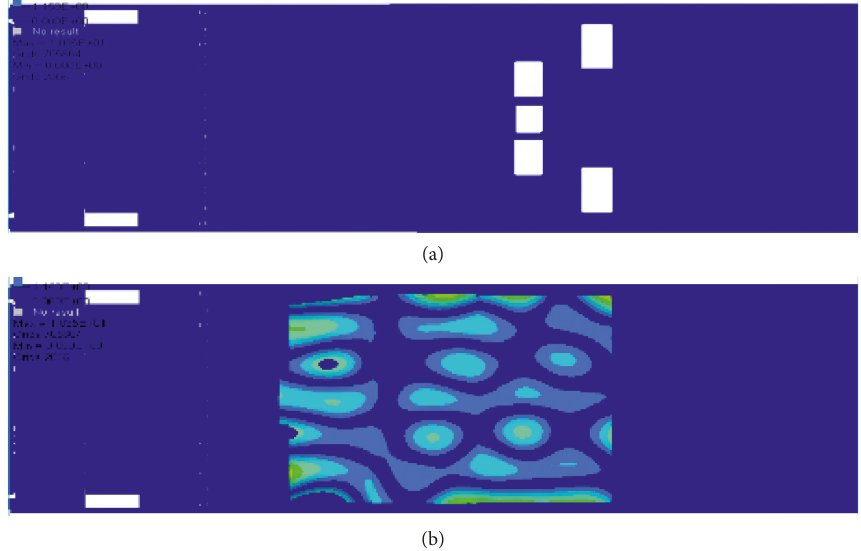
Figure 16: Modal shape comparison between (a) underframe of car body (92 Hz) and (b) floor.